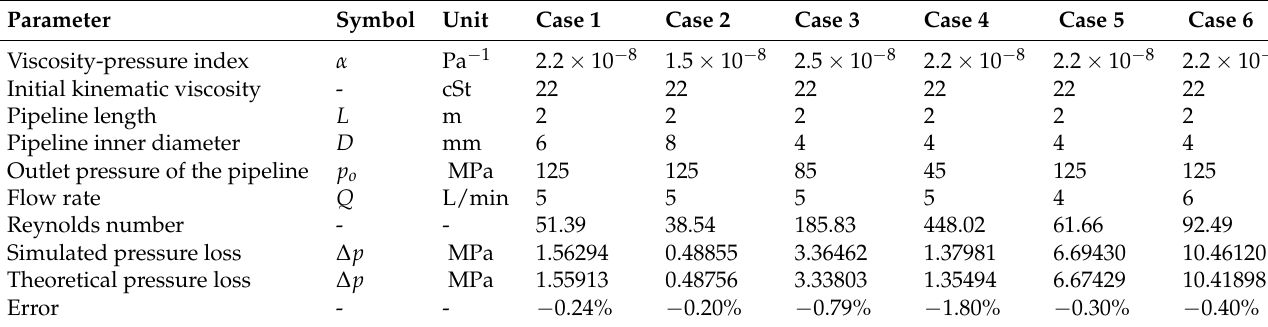
Table 4. Variable inputs and pressure losses: part